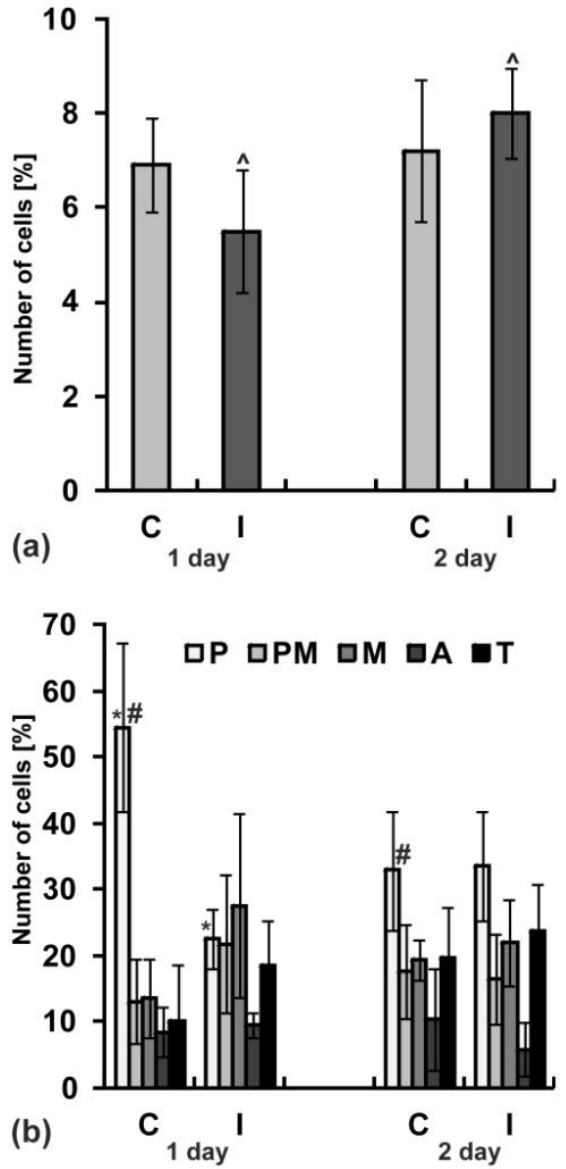
Figure 7. Mitotic activity in yellow lupine root meristems after one and two days of seed germination. The seeds collected from not irrigated (control—C) and irrigated—I plants. ( a ) Mitotic index, ( b )